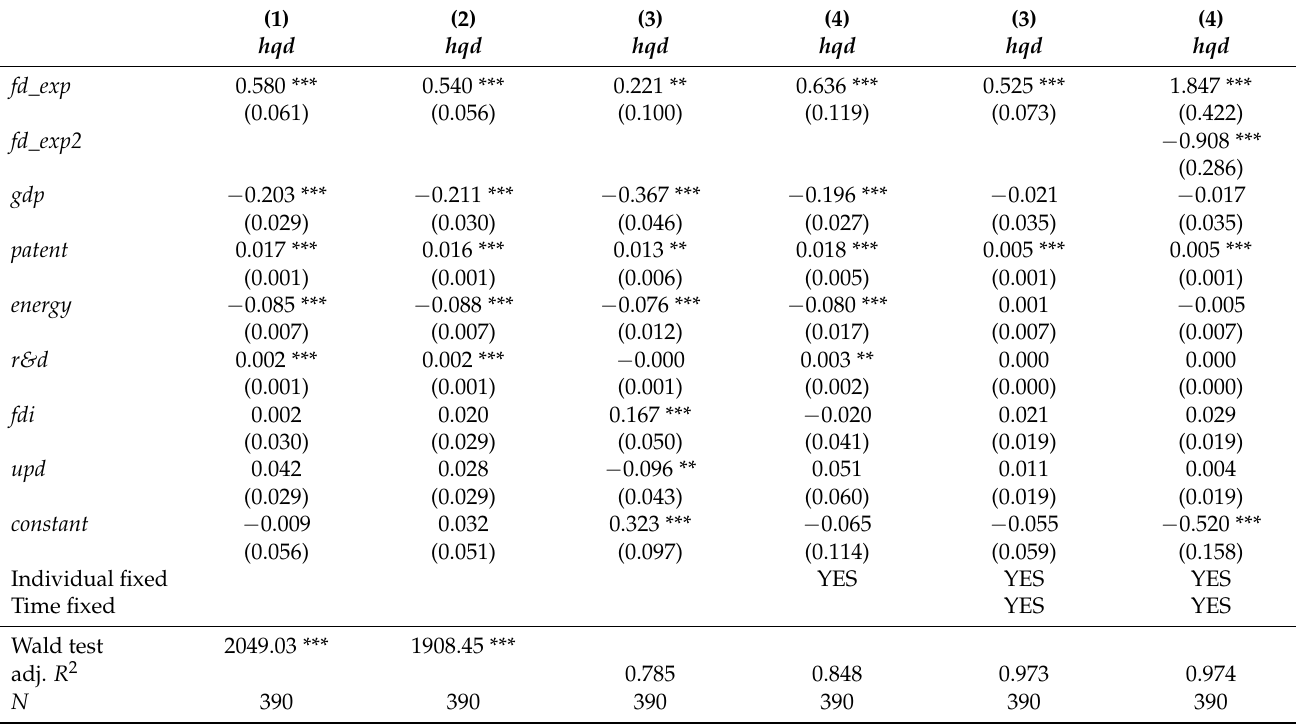
Table 4. Baseline regression